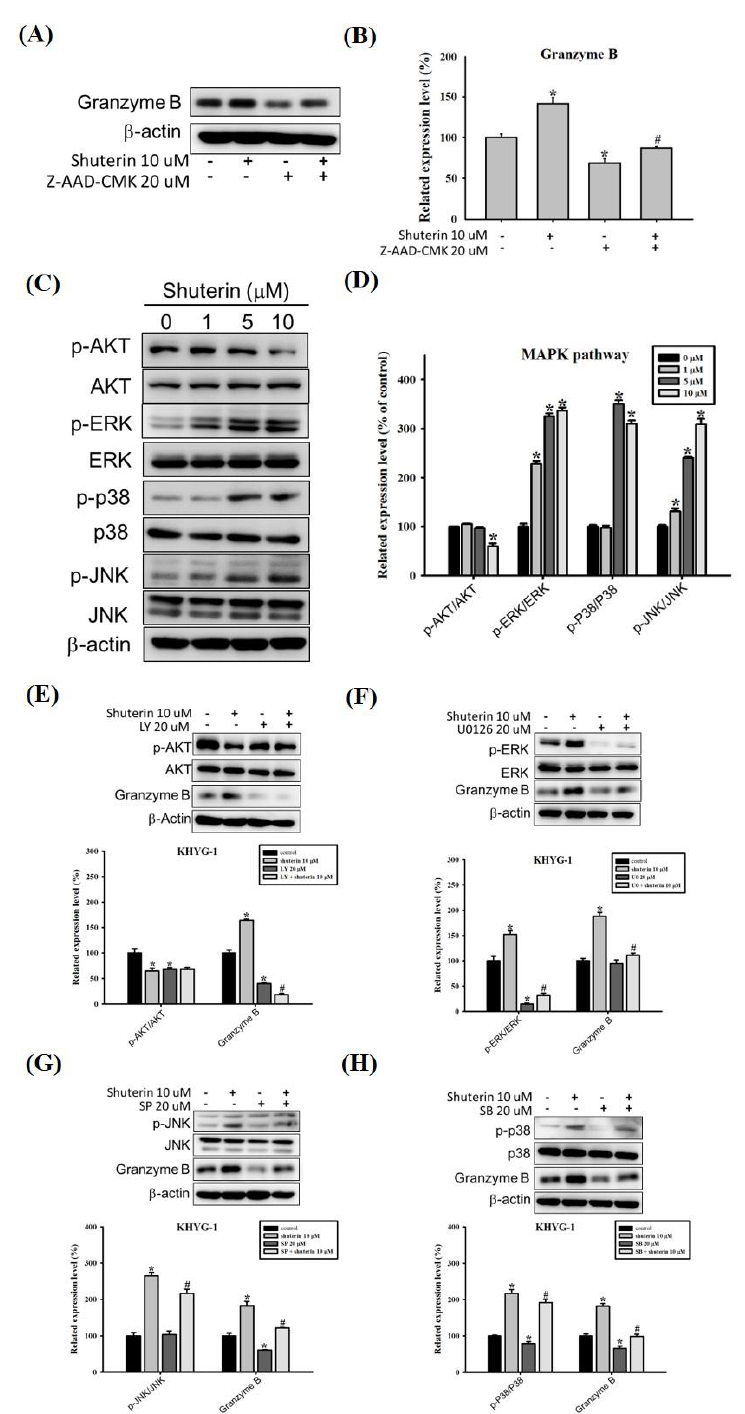
Figure 4. Mechanisms underlying the shuterin-induced increase in granzyme B expression through the MAPK pathway. Cells were pretreated with various inhibitors (Z-AAD-CMK/granzyme b, LY-294002/AKT, U0126/ERK, SP-600125/JNK, and SB-203580/P38) for 1 h or left untreated; subsequently, these cells were treated with shuterin for 24 h. Protein levels were quantified through Western blotting and normalized to beta-actin levels using a densitometer. Granzyme B and granzyme b inhibitors ( A , B ); PI3K/AKT and MAPK pathway ( C , D ); p-AKT/AKT ( E ); p-ERK/ERK ( F ); p- JNK/JNK ( G ) and p-p38/p38 ( H ) * p < 0.05 V.S. control, # p < 0.05 V.S. inhibitor-treated